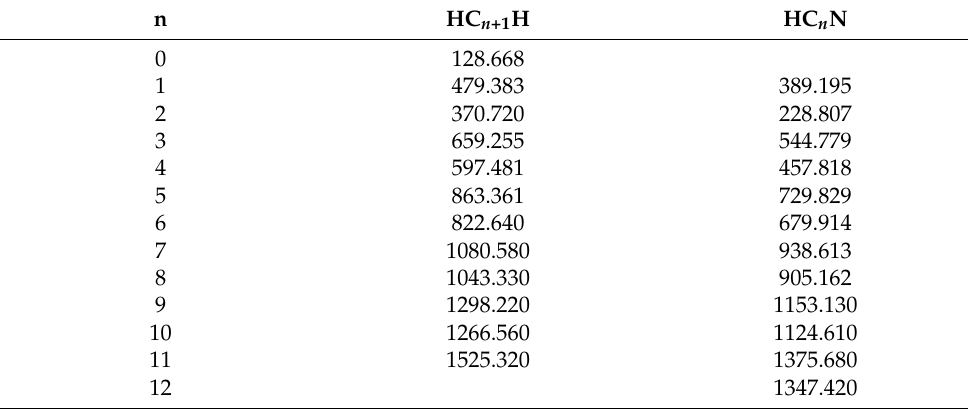
Table A1. Enthalpies of formation of the isoelectronic HC n + H and HC n N chain species computed using the G4 composite model. All values are in kJ/mol.